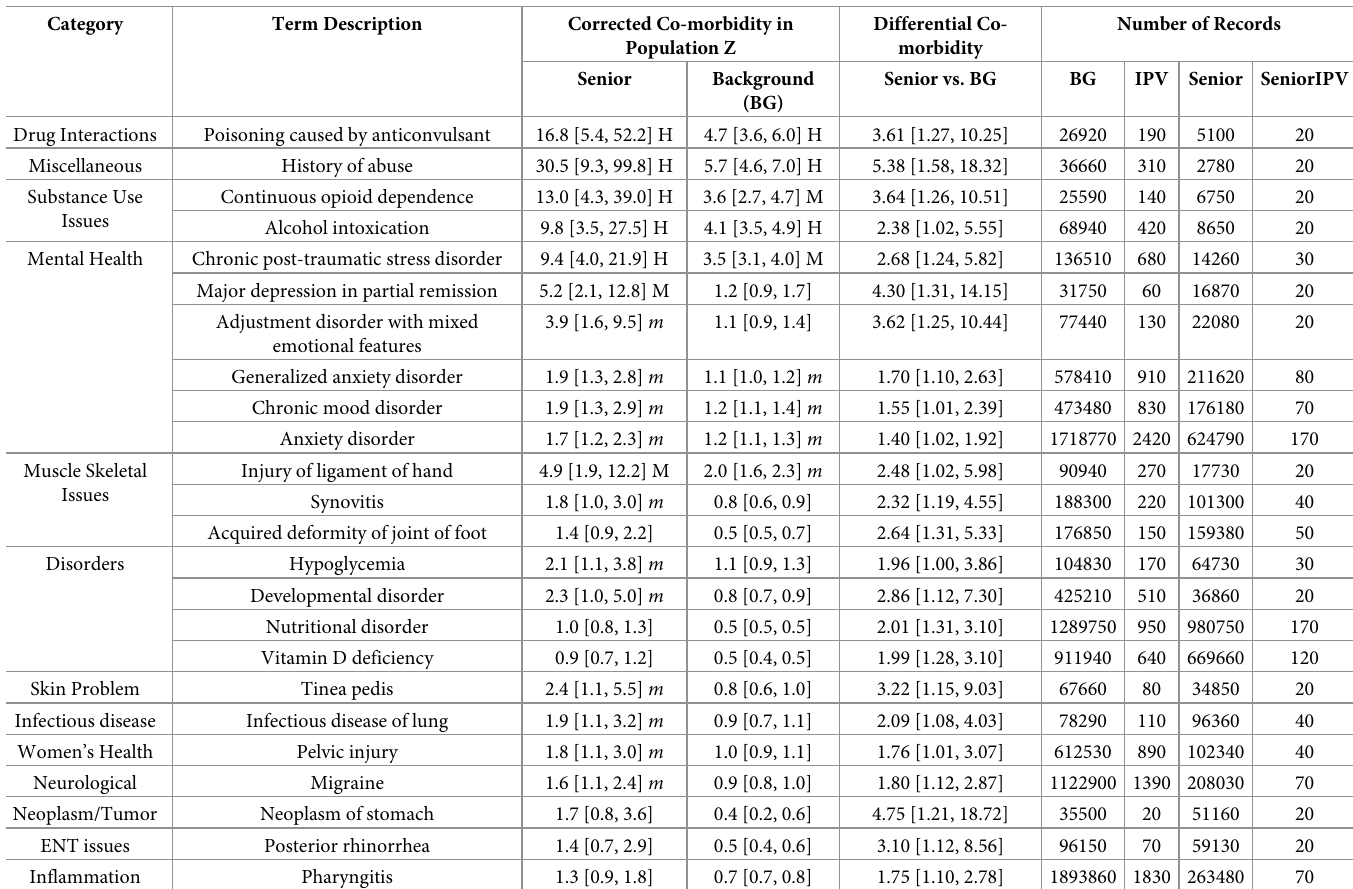
Table 2. Terms that exhibit higher co-morbidity with IPV in older women population compared to the background (BG) population. For each term, we provide the co-morbidity scores for Senior and BG populations (after correcting for detecting bias), and the differential co-morbidity score. For each co-morbidity score, we report the following: The point estimate (odds ratio), 95% augmented confidence interval corrected to bound FDR, and the corresponding co-morbidity level. The co-morbidity lev- els are abbreviated: H for high, M for moderate, and m for minor. All 20 reported terms are identified as differentially co-morbid with high confidence (this indicates that they exhibit higher association with IPV in older women population compared to the BG population in a statistically significant manner). See S3 Data for a full list of terms identified as significant and their assigned categories. OR: Odds ratio, IPV: Intimate partner